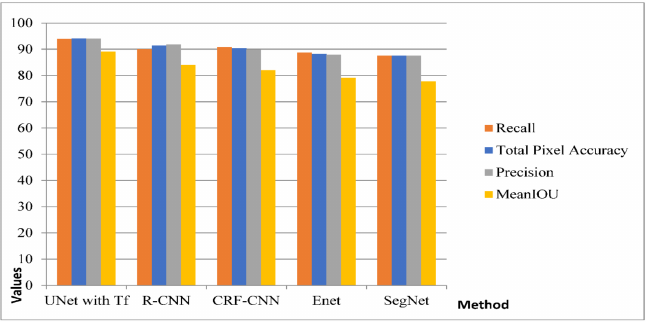
Figure 14. Comparison of Methods with different metrics.